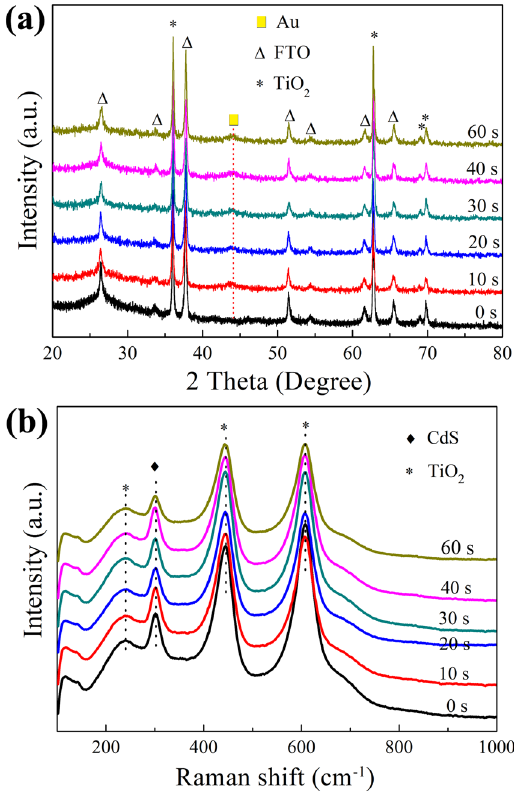
Figure 1. ( a ) XRD patterns and ( b ) Raman spectra of TiO 2